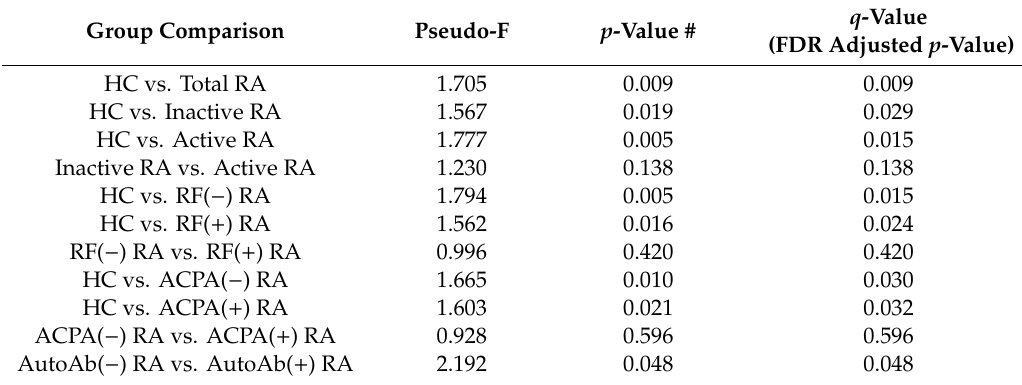
Table 2. The PERMANOVA results of the unweighted UniFrac distances between rheumatoid arthritis (RA) patients and healthy controls